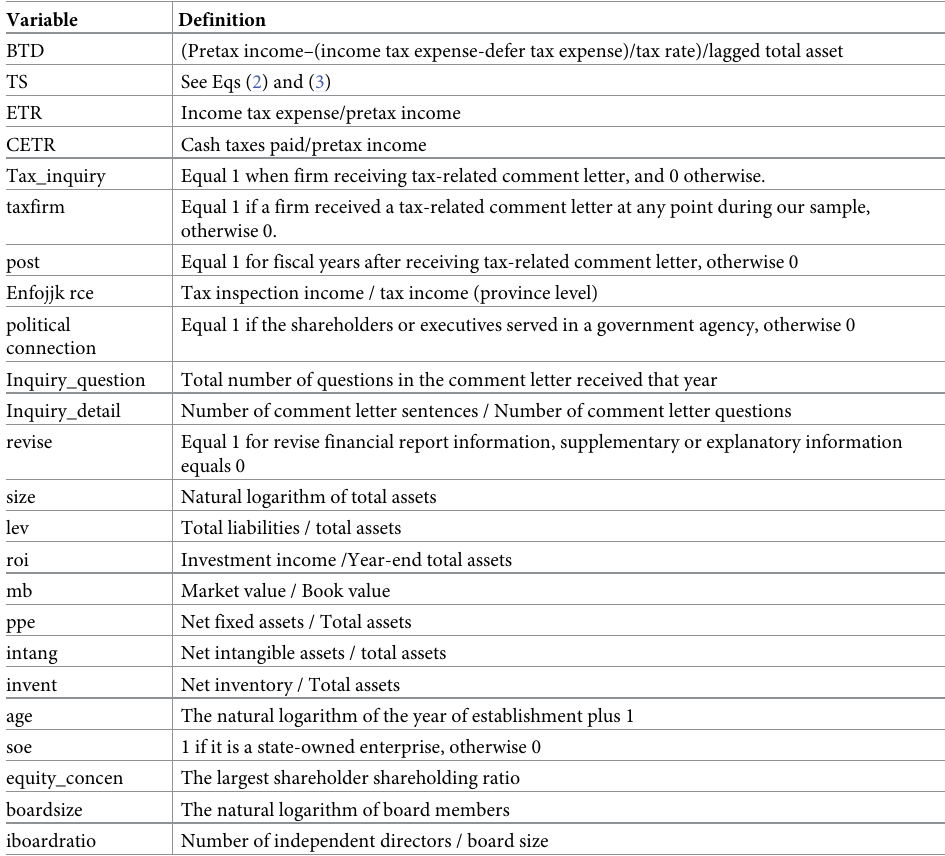
Table 2. Variables